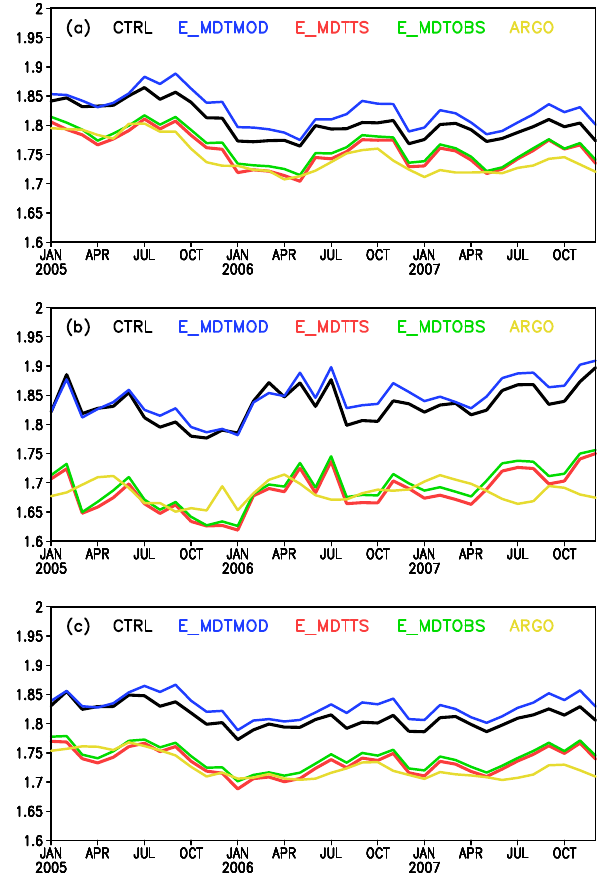
Figure 5. Time series of sea surface dynamic height (unit: m) av- eraged over the Pacific Ocean (a) , Indian Ocean (b) , and Indian– Pacific oceans (c) from different experiments. Black: CTRL; blue: E_MDTMOD; red: E_MDTTS; green: E_MDTOBS; yellow: Argo